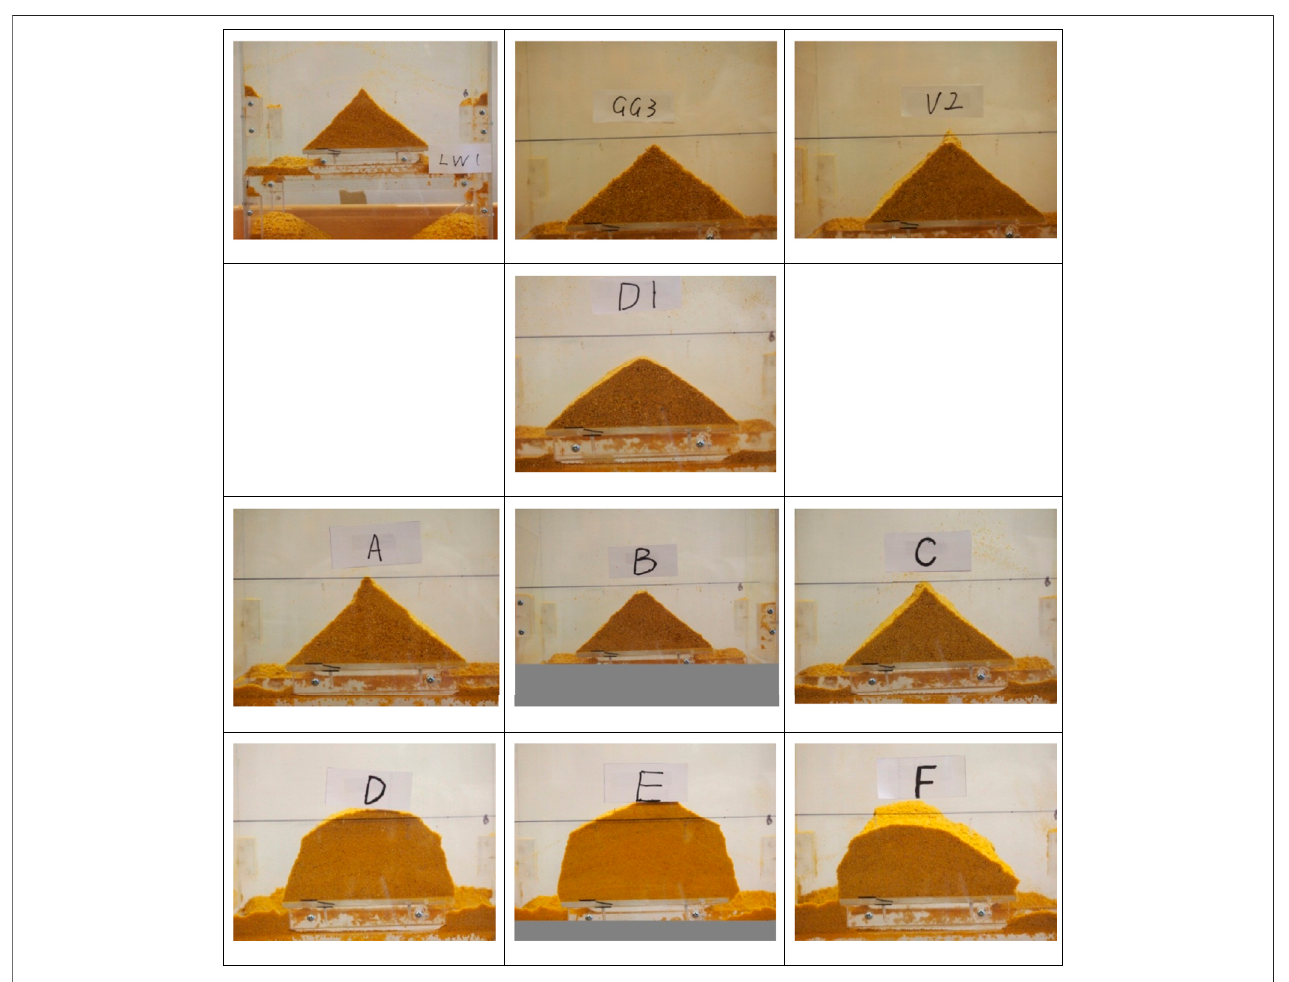
FIGURE 1 | Angle of repose tests of distillers dried grains with solubles (DDGS) samples using a Helle-Shaw cell – note the drastic differences amongst the DDGS sources. All appear to have poor fl ow characteristics.